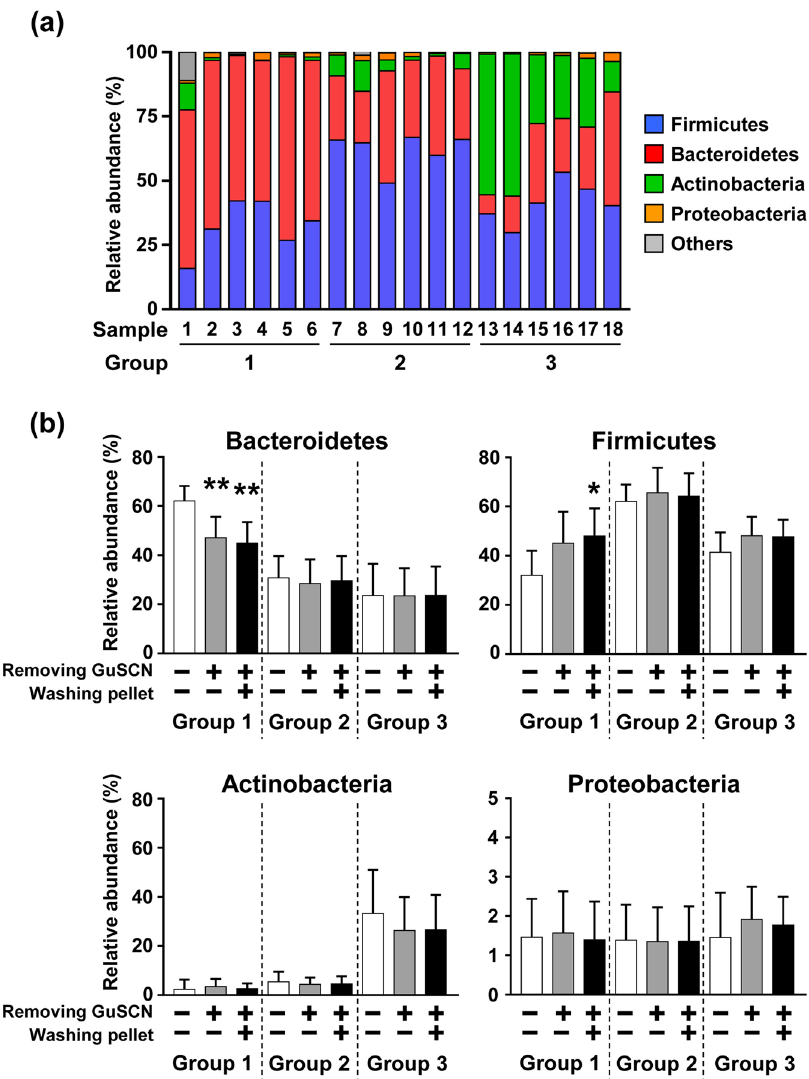
Figure 1. Effects of pretreatment on microbial composition in fecal samples stored in GuSCN solution. ( a ) Microbial composition of fecal samples from 18 healthy individuals at the phylum level. DNA was extracted directly from fecal samples in GuSCN solution by the bead beating method and sequenced. ( b ) Relative abundance of Bacteroidetes, Firmicutes, Actinobacteria, and Proteobacteria before and after pre-treatment in the DNA extraction procedure is shown. Data are presented as means ± SD (n = 6). An asterisk means statistically significant difference as calculated by using Student’s t test ( * p < 0.05, ** p <